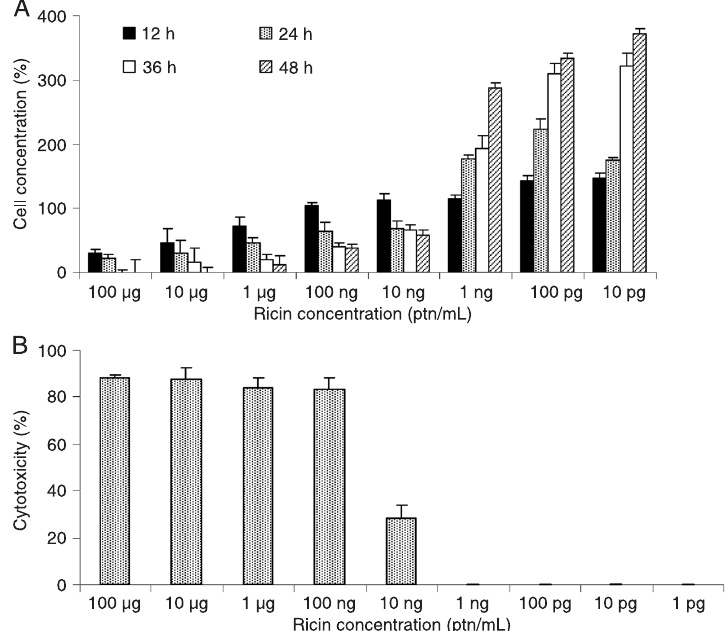
Figure 2. Limit of detection of ricin in a Vero cell culture. A , Cell concentration (estimated by cell counting) after treatment with different quantities of ricin. B , Cy - totoxicity measured using a lactate dehydrogenase assay. ptn = protein.